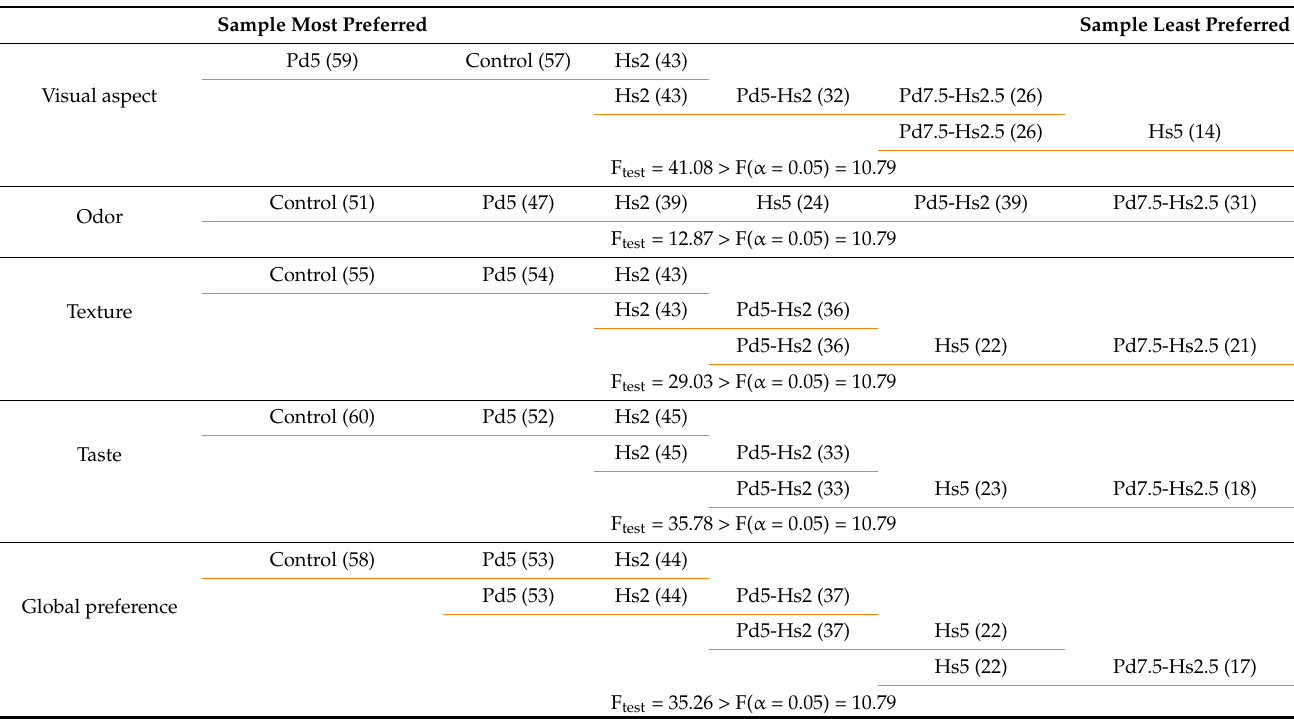
Table 7. Preference test results of beef